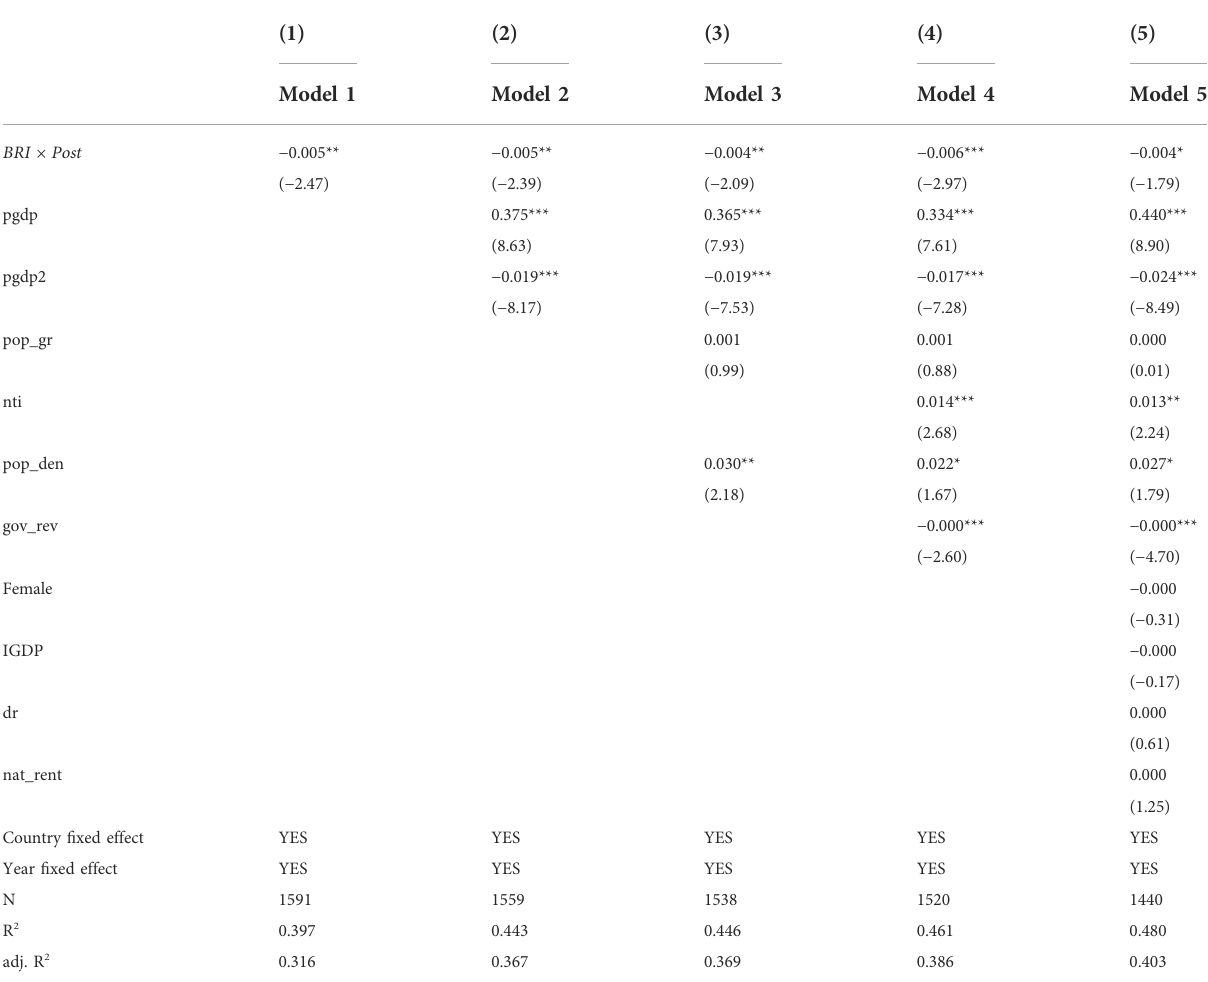
TABLE 5 Effects of the Belt and Road Initiative on environmental quality: